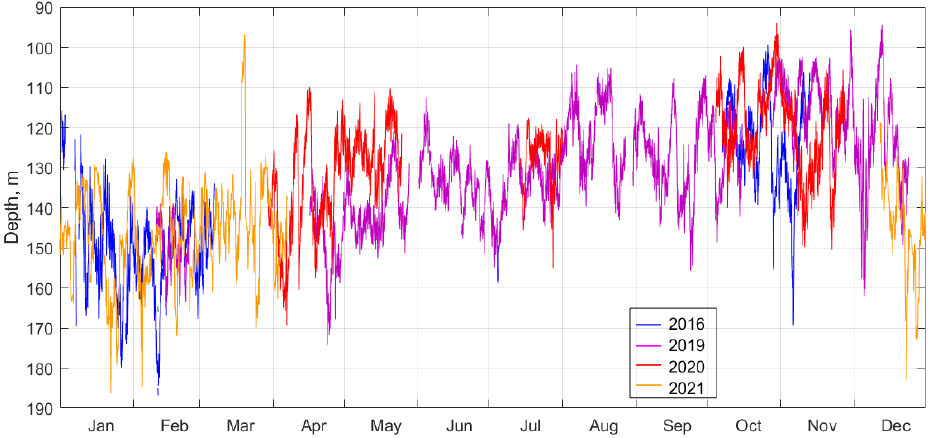
Figure 15. The suboxic boundary depth ([O 2 ] = 10µm) as observed by the moored profiler in 2016, 2019, 2020, and